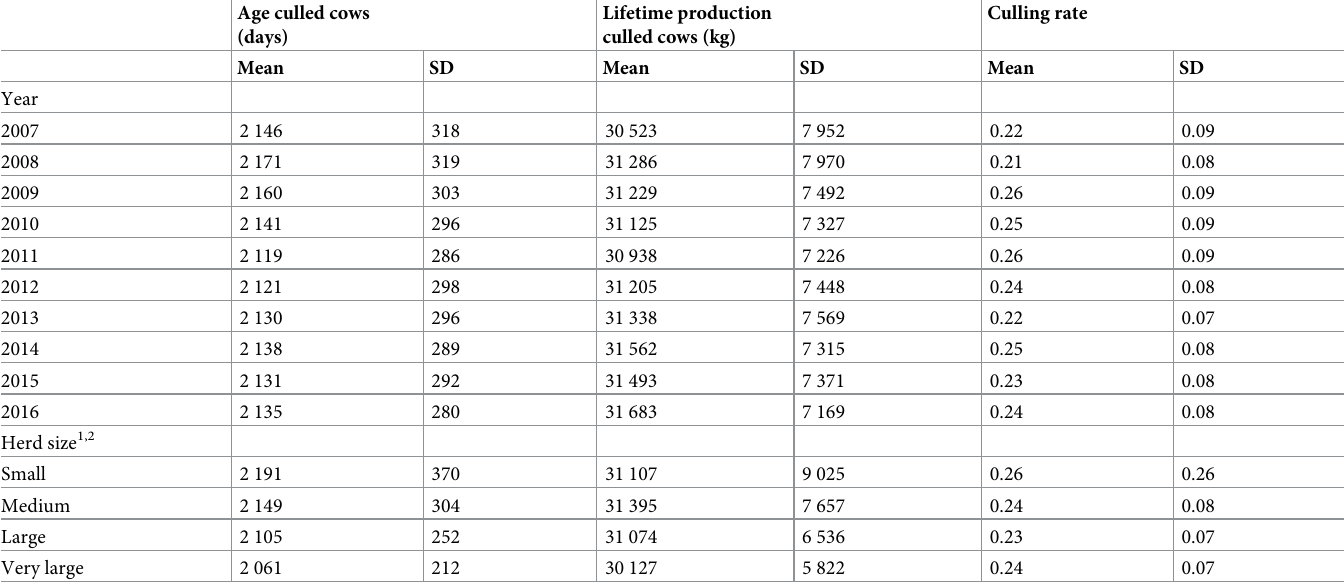
Table 2. Herd averages on age of culled milking cows (days), lifetime milk production of culled cows (kg) and culling rate with SD by year and herd size. Age culled cows (days)